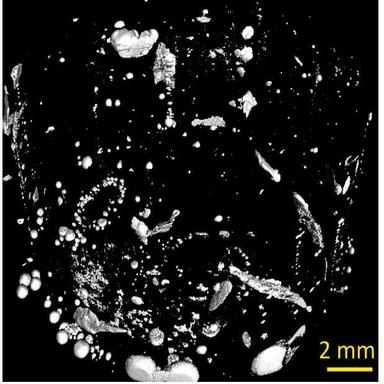
Three-dimensional image of the mercury drops expelled from the sample body (P-05-600) to the coated epoxy resin (∼1.2 mm thick around the sample body).